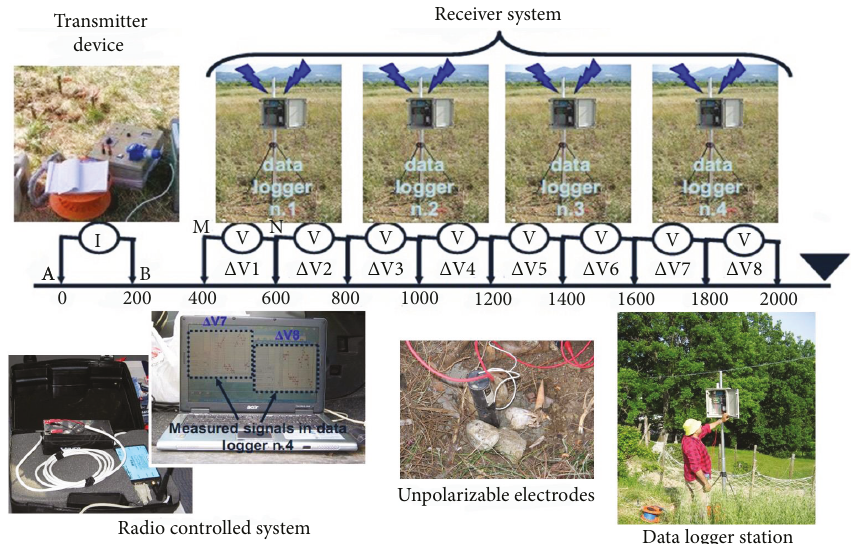
Figure 3: Geoelectrical prototype for Deep Electrical Resistivity Tomography, made by